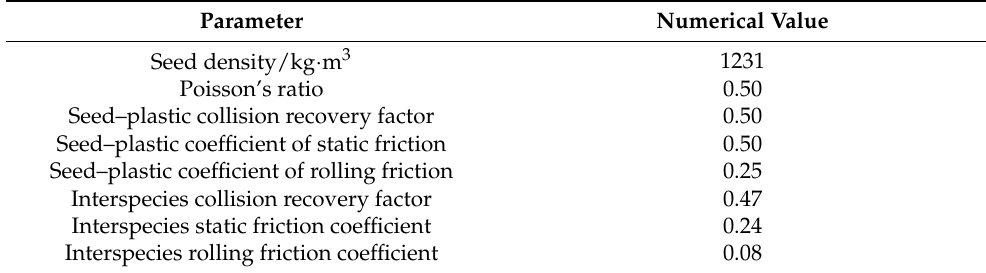
( b ) Figure 6. Discrete element model of screw conveyor: ( a ) conveyor model with a seed stirring mech- anism, and ( b ) conveyor model without a seed stirring mechanism. 3.2. EDEM and ADAMS Co-Simulation Test When only using EDEM to numerically simulate the working process of the screw conveyor with the seed stirring mechanism, the force transmission between the auger